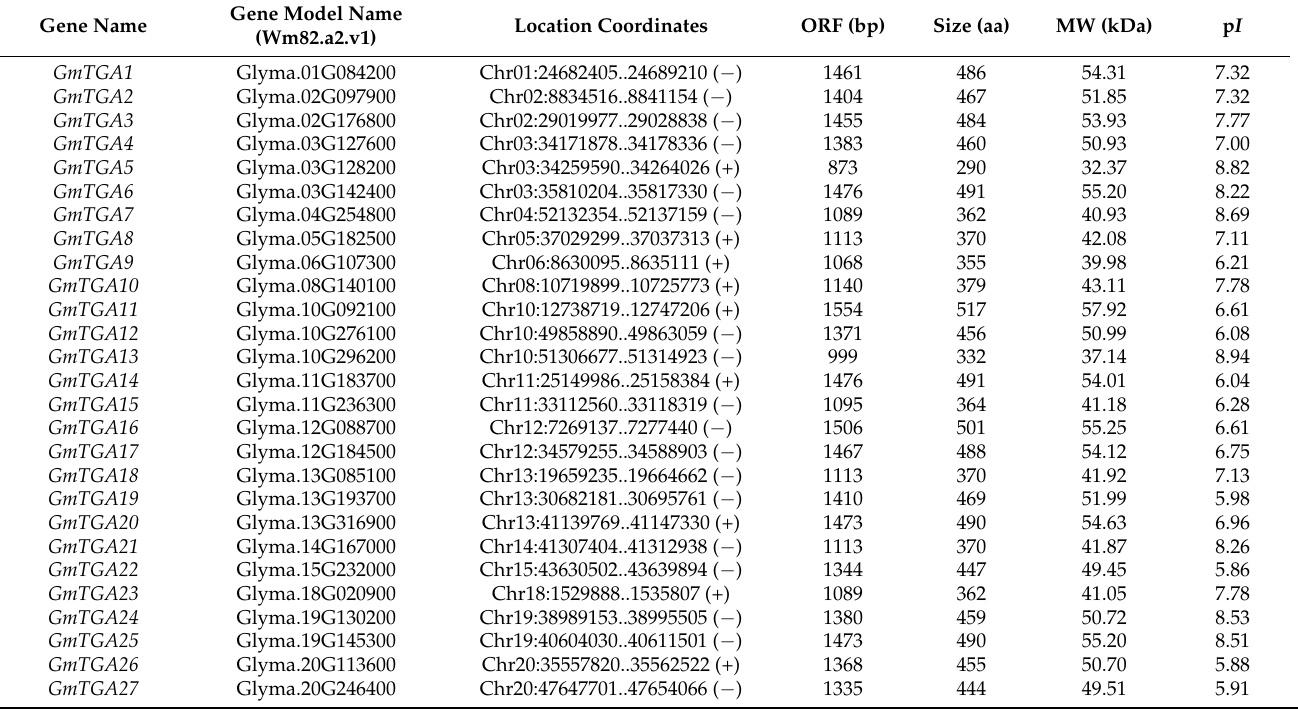
Table 1. Characteristics and nomenclature of soybean TGA transcription factors in soybean cultivar NN1138-2 . Gene Model Name Gene Name